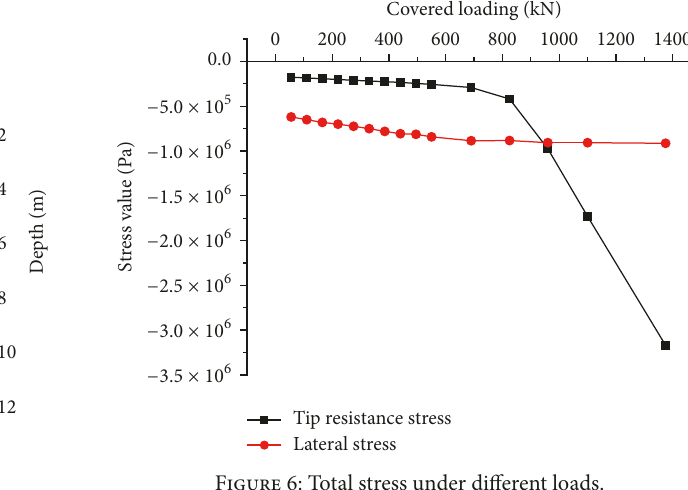
Figure 6: Total stress under different loads.